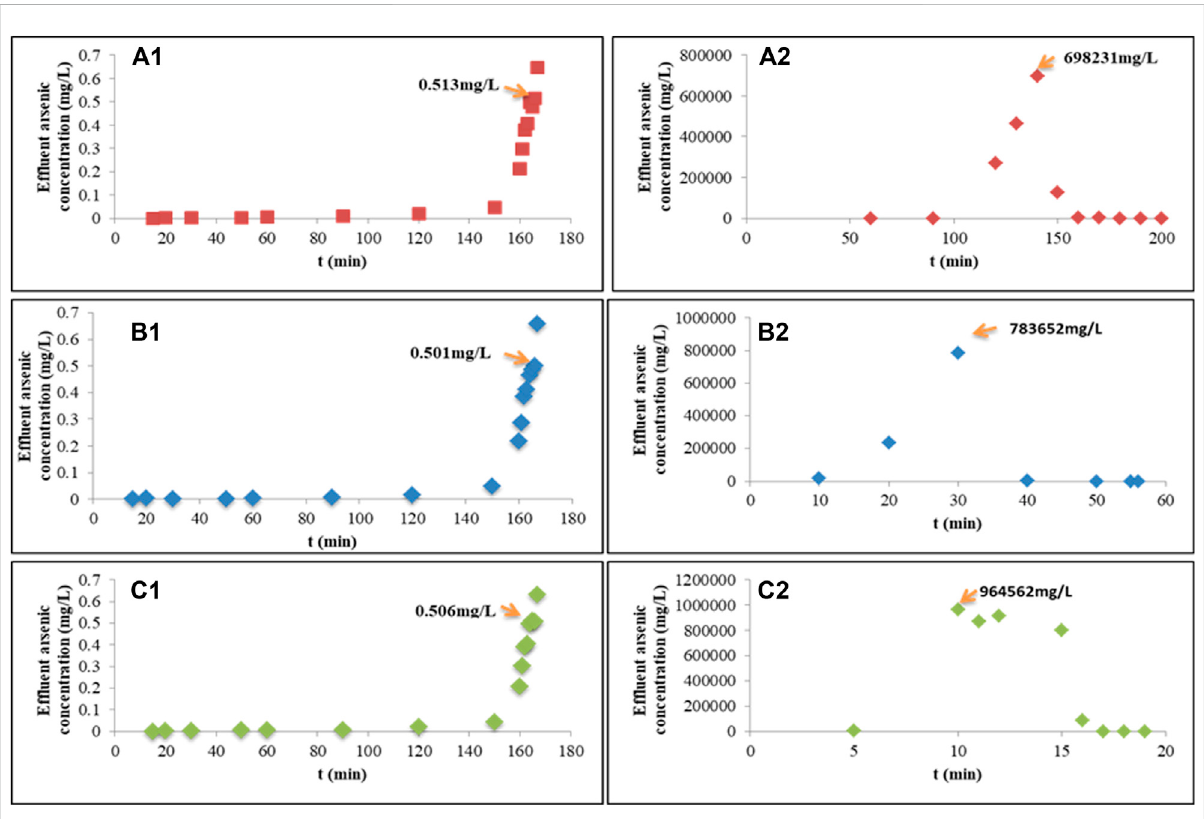
FIGURE 4 Adsorption breakthrough curves at the breakthrough point of 0.5 mg/L and back fl ushing curves using 1 M of NaOH with different velocities of the fl ow. (A1) Adsorption curves and (A2) the corresponding back fl ushing curve with an inlet velocity of fl ow = 0.1 ml/s; (B1) adsorption curves and (B2) the corresponding back fl ushing curve with an inlet velocity of fl ow = 0.5 ml/s; (C1) adsorption curves and (C2) the corresponding back fl ushing curve with an inlet velocity of fl ow = 1